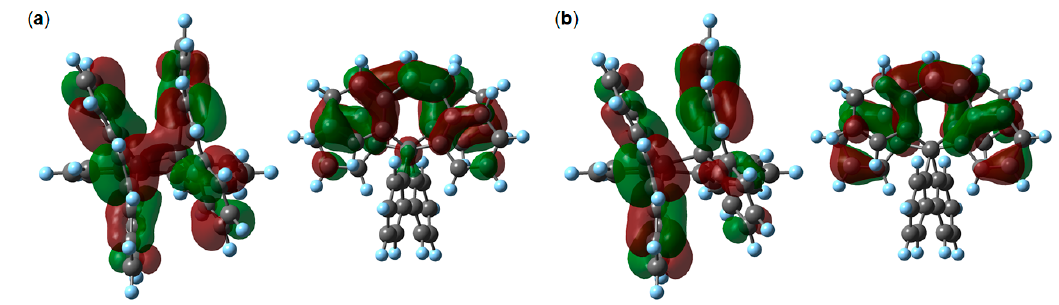
Figure 5. ( a ) HOMO and ( b ) next-highest OMO (NHOMO) of 1 based on DFT calculations (B3LYP/6-